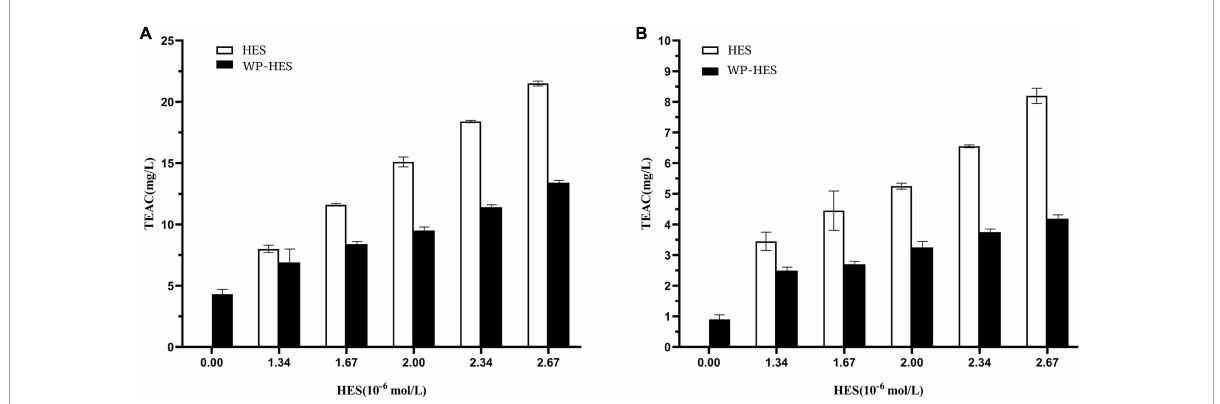
FIGURE6 The visual appearance of WP-based emulsion (A) , WP-HES (1 mM) based emulsion (B) , and WP-HES (2 mM) based emulsion (C) under different pH values (numbers on the tubes).